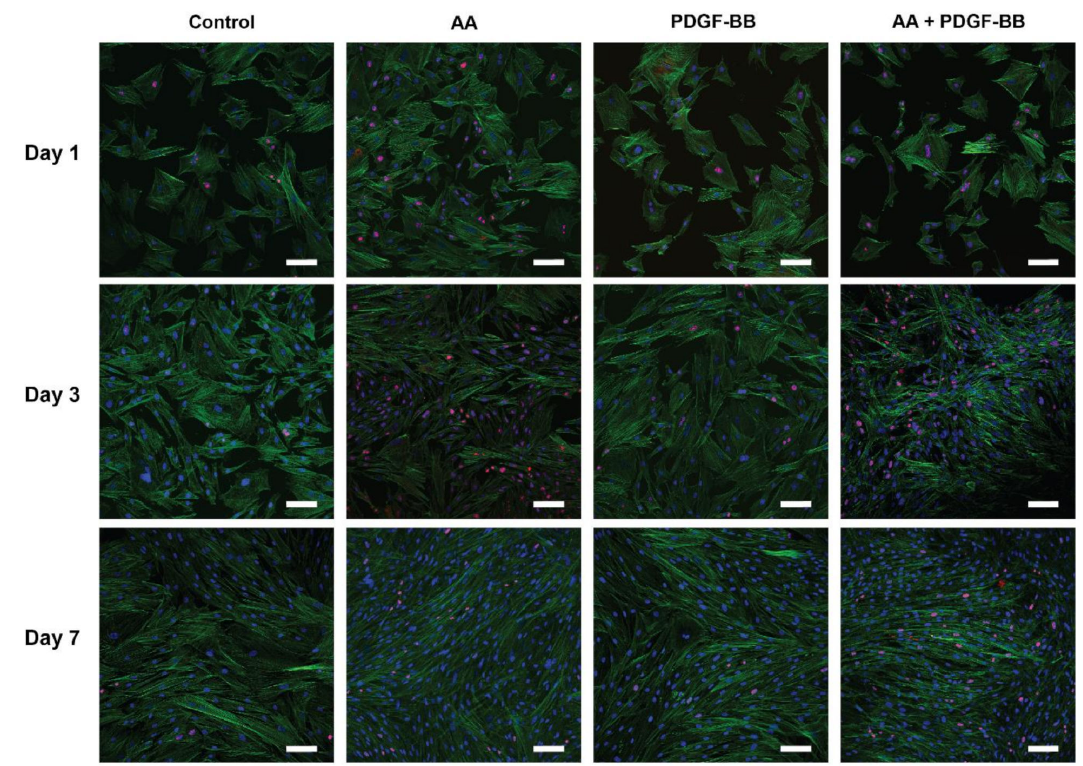
Figure 2. E ff ect of AA and PDGF-BB on tenocyte proliferation and morphology in cell culture. Representative CLSM images of tenocytes cultured in serum + medium for a period of 7 days and supplemented with either AA (10 µ g / mL), PDGF-BB (25 ng / mL), combination of AA (10 µ g / mL) + PDGF-BB (25 ng / mL), or untreated (control). Cells were stained with phalloidin (green) for visualizing the cytoskeleton, ki-67 (red) as a proliferation marker, and DAPI (blue). Scale bars: 100 µ